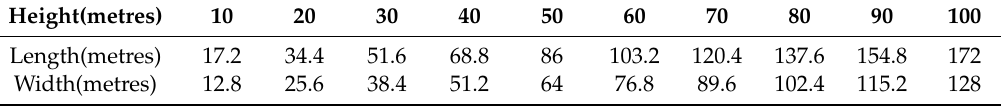
Figure 4. Photos taken by drones at different heights.